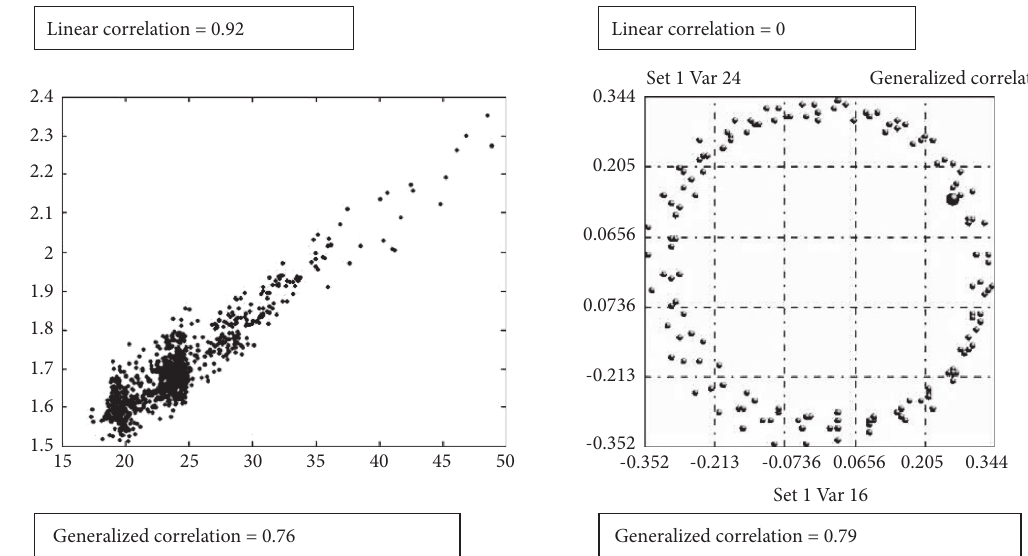
Figure 2: Examples of linear and generalised